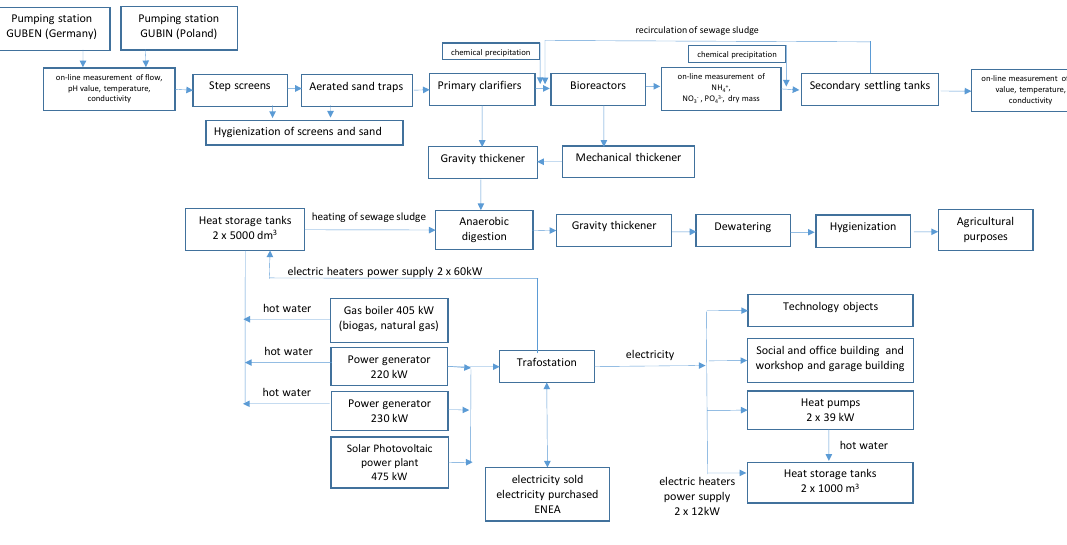
Figure 4. The technological scheme of Gubin–Guben WWTP .